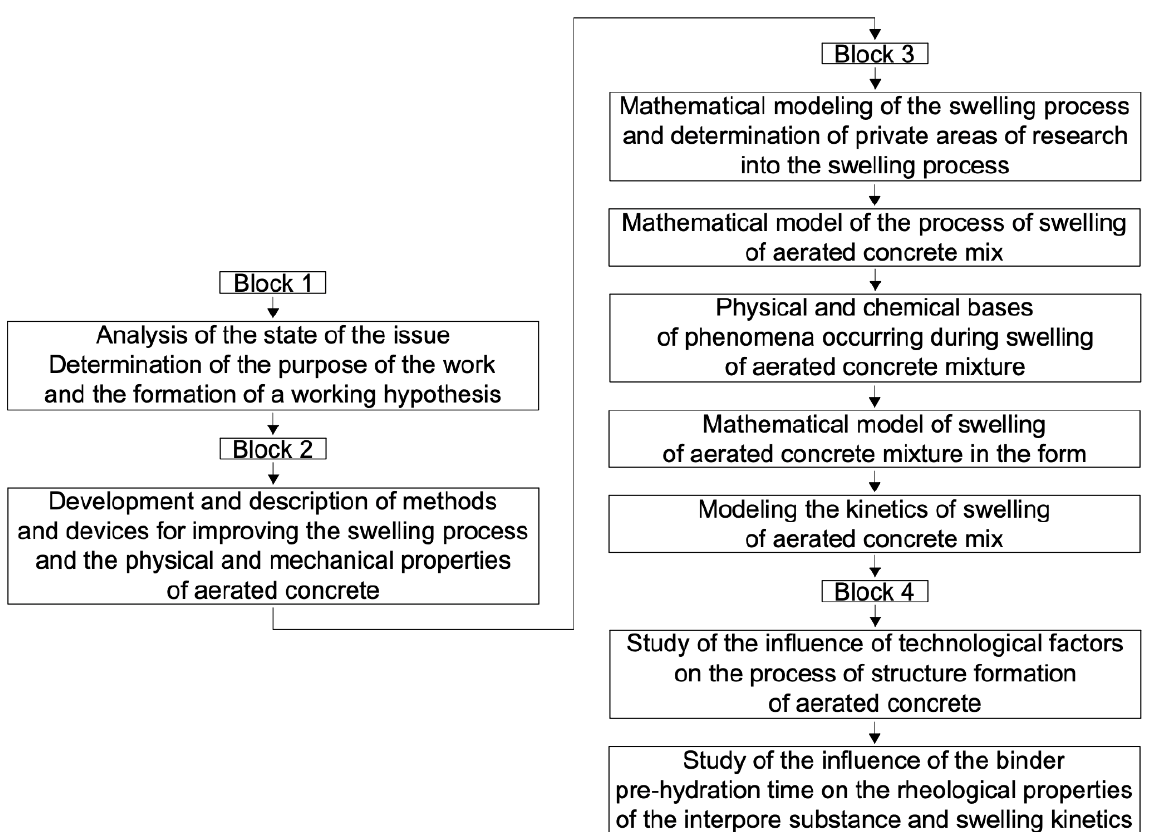
Figure 1. Structural and logical block diagram of the study plan.